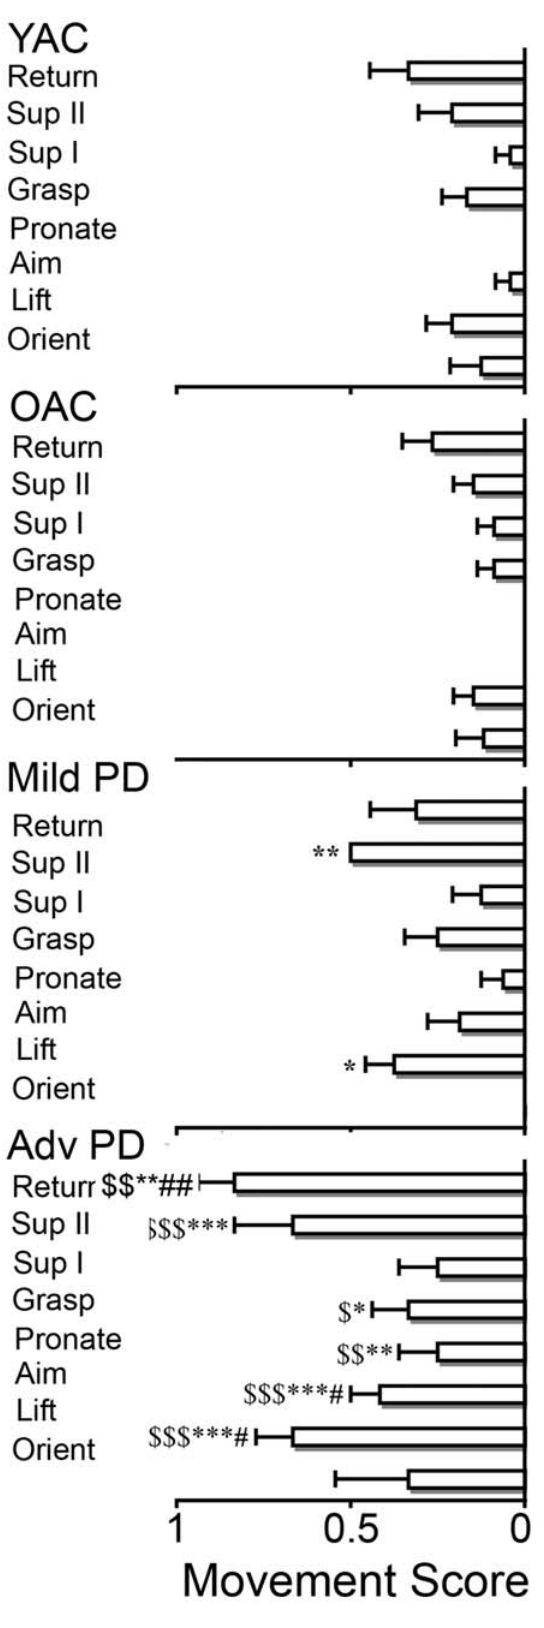
Figure 4. Movement element score (mean and standard error) for the four experimental groups. $ =advanced PD . YAC; $$ =ad- vanced PD . OAC; *=advanced PD . mild PD.